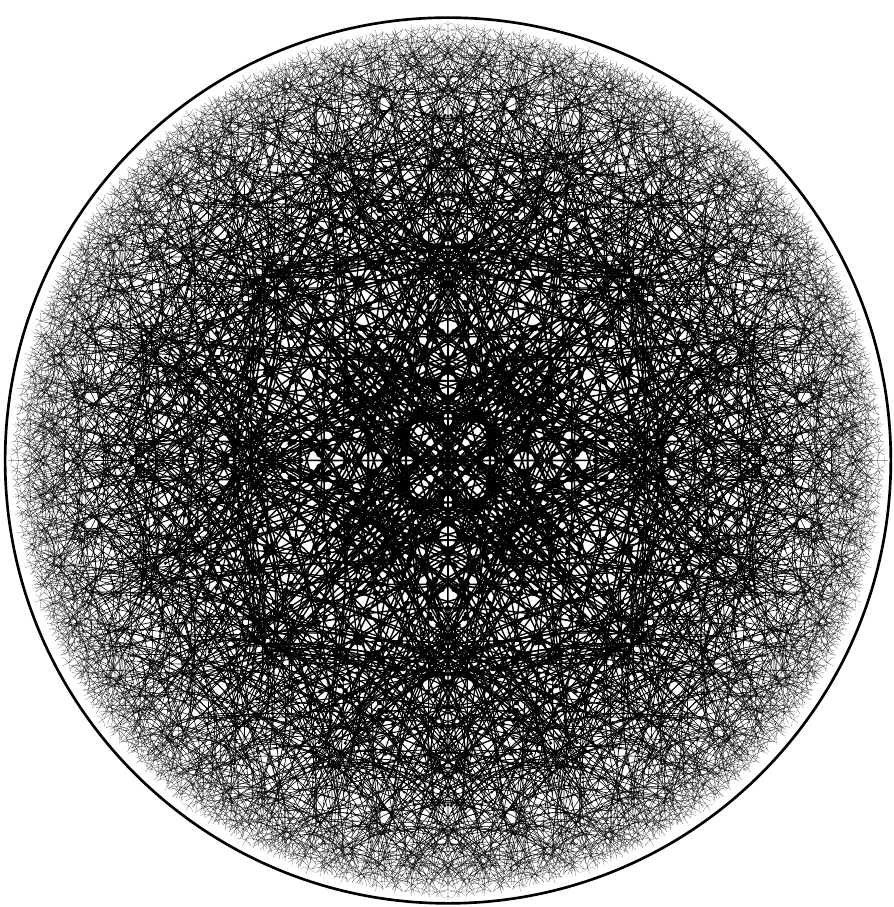
Figure A1. M 8 , the disk that would directly succeed M 7 shown in Figure